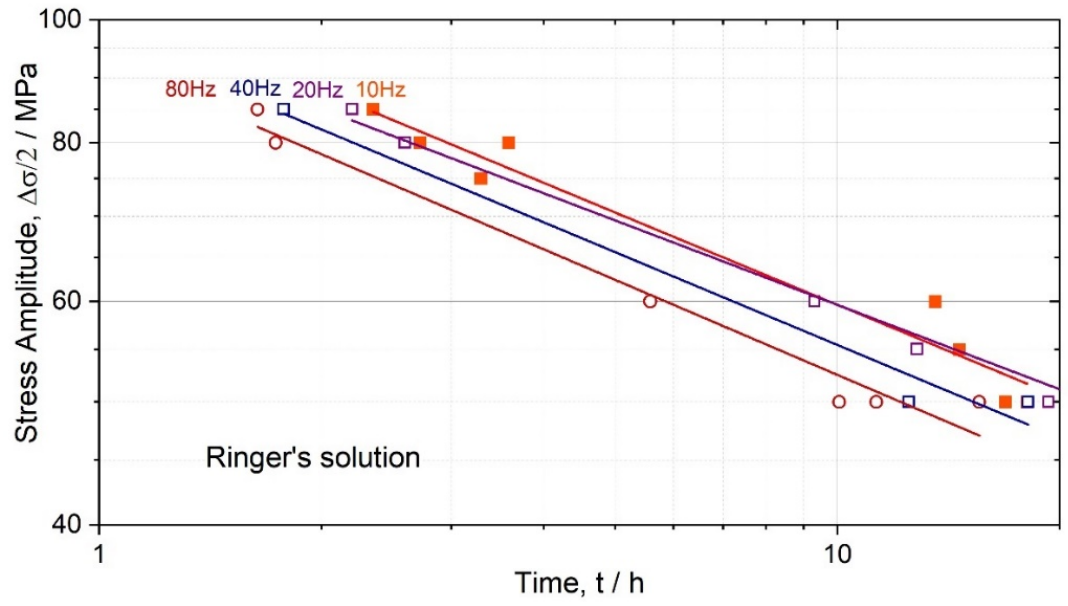
Figure 12. Fatigue diagrams for the ZK60 specimens plotted as the stress amplitudes vs. fatigue time, corresponding to different testing frequencies in Ringer’s solution.